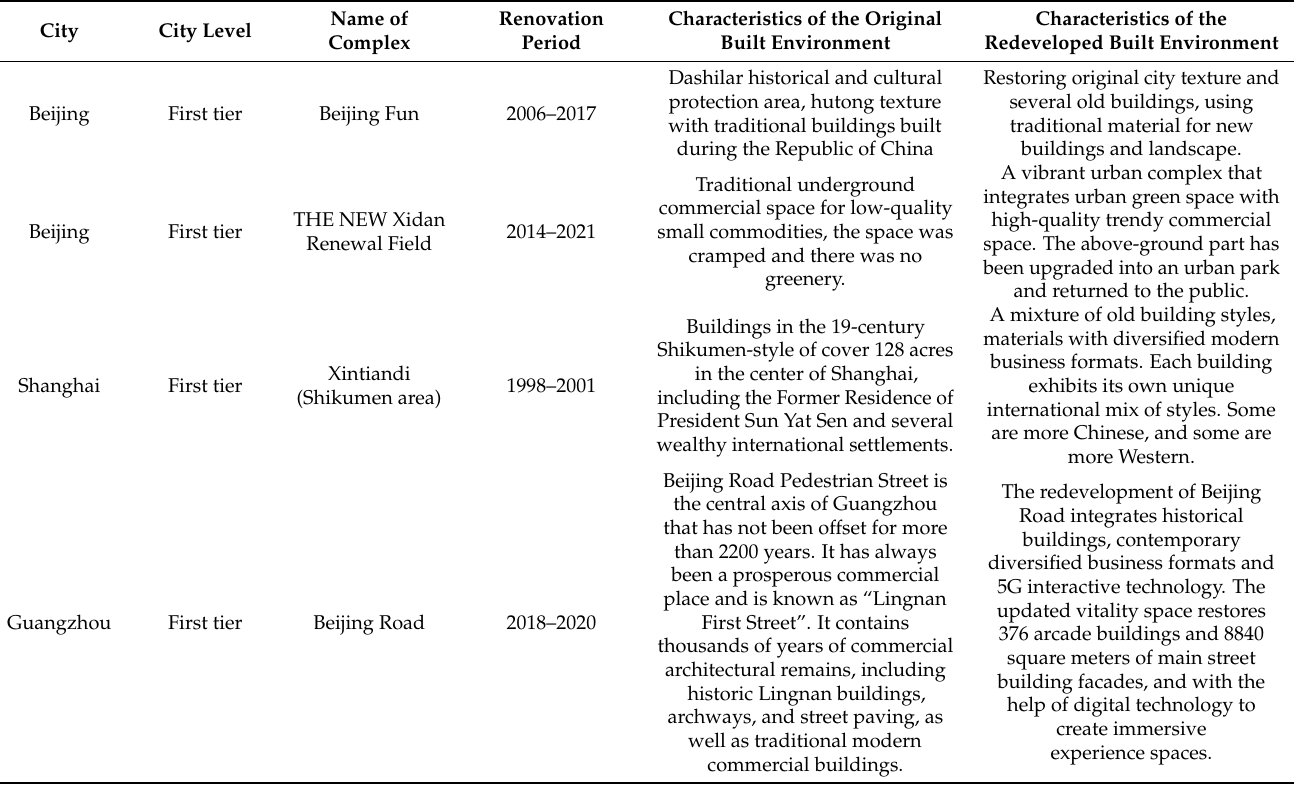
Table 1. Overview of the basic conditions and characteristics of the five urban renewal